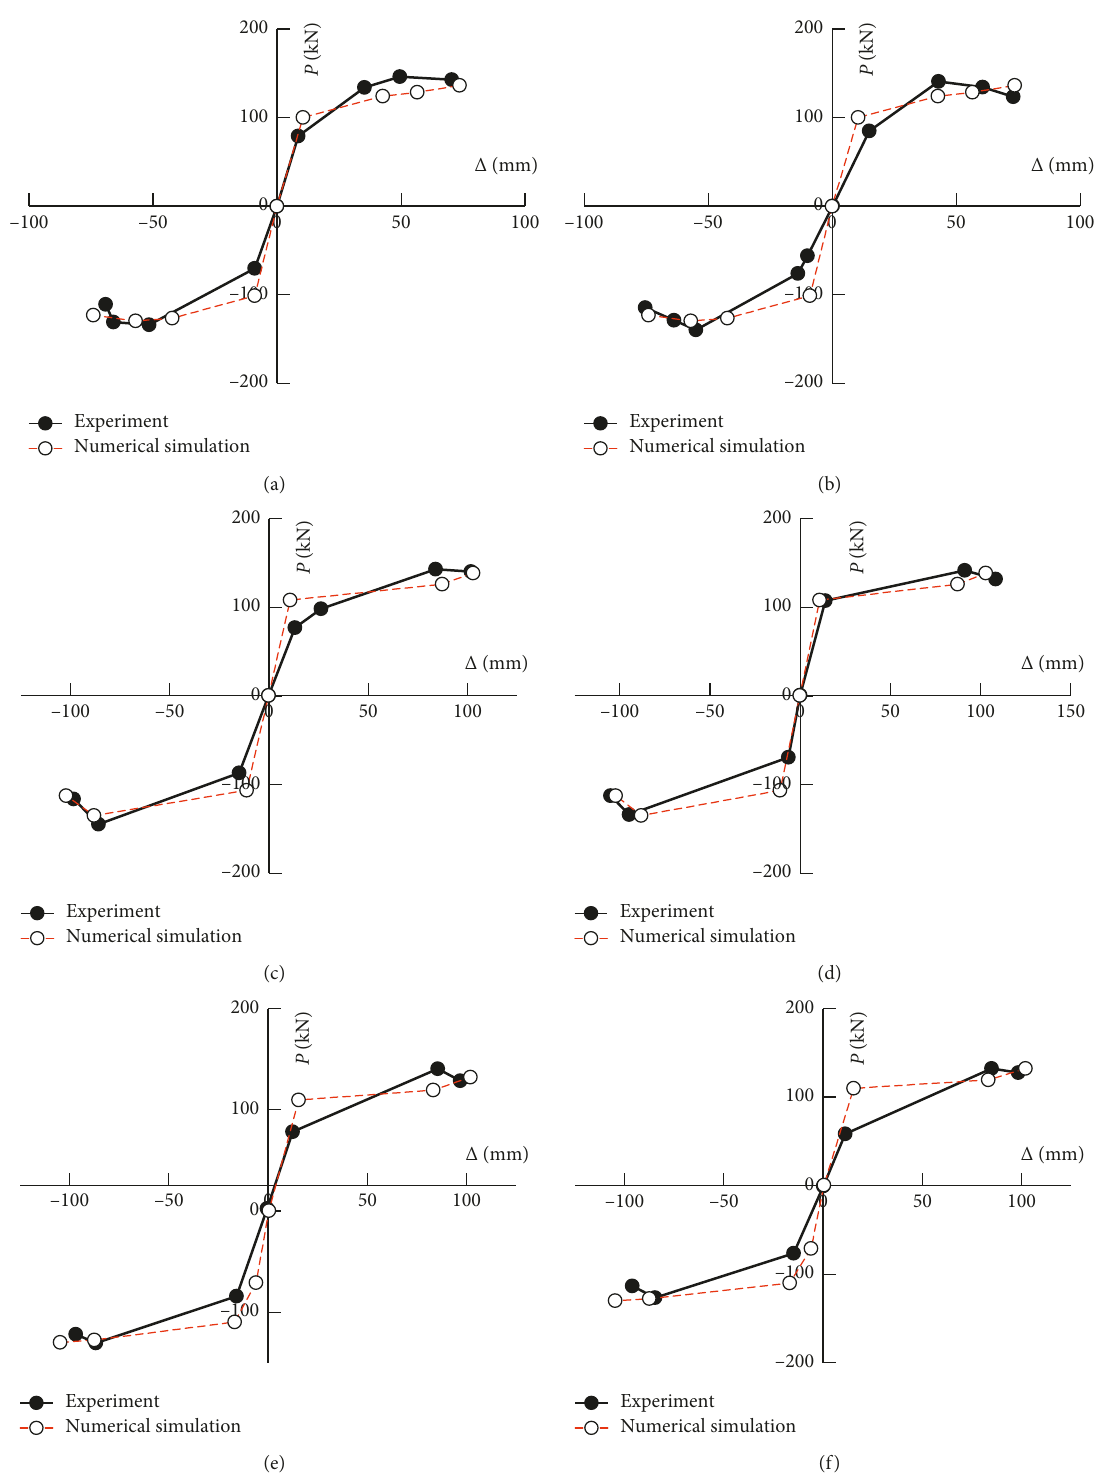
Figure 9: Comparison on load-displacement skeleton curves between FEA results and experiment results. (a) Specimen A1. (b) Specimen A2. (c) Specimen B1. (d) Specimen B2. (e) Specimen C1. (f) Specimen